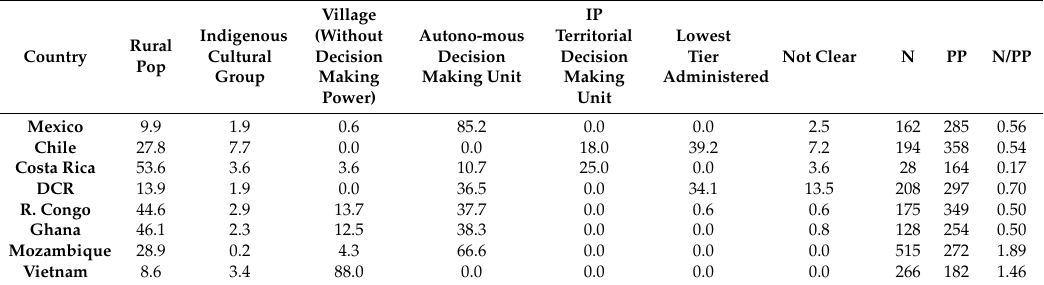
Table 3. Meanings of the term ‘community’ in the Emissions Reduction Programs (ERP) documents submitted to the Forest Carbon Partnership Facility FCPF (frequency of occurrence in %). N—number of relevant references to the term ‘community’ in the national report; PP—pages; N/PP average occurrence of the term ‘community’ per page of the